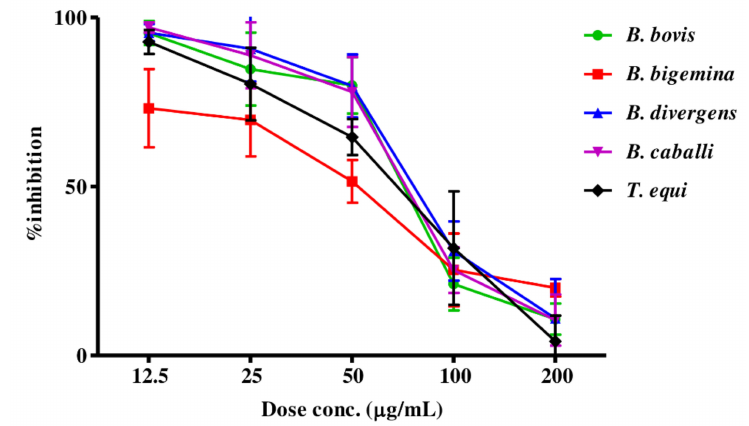
Figure 2. Dose-response curves of AERC against Babesia and Theileria parasites in vitro. The curves showing the correlation between the percentage of inhibition and the concentration of AERC ( µ g / mL) on B. bovis , B. bigemina , B. divergens , B. caballi and T. equi . The values obtained from three separate trials were used to determine the IC 50 ’s using the non-linear regression (curve fit analysis) in GraphPad Prism